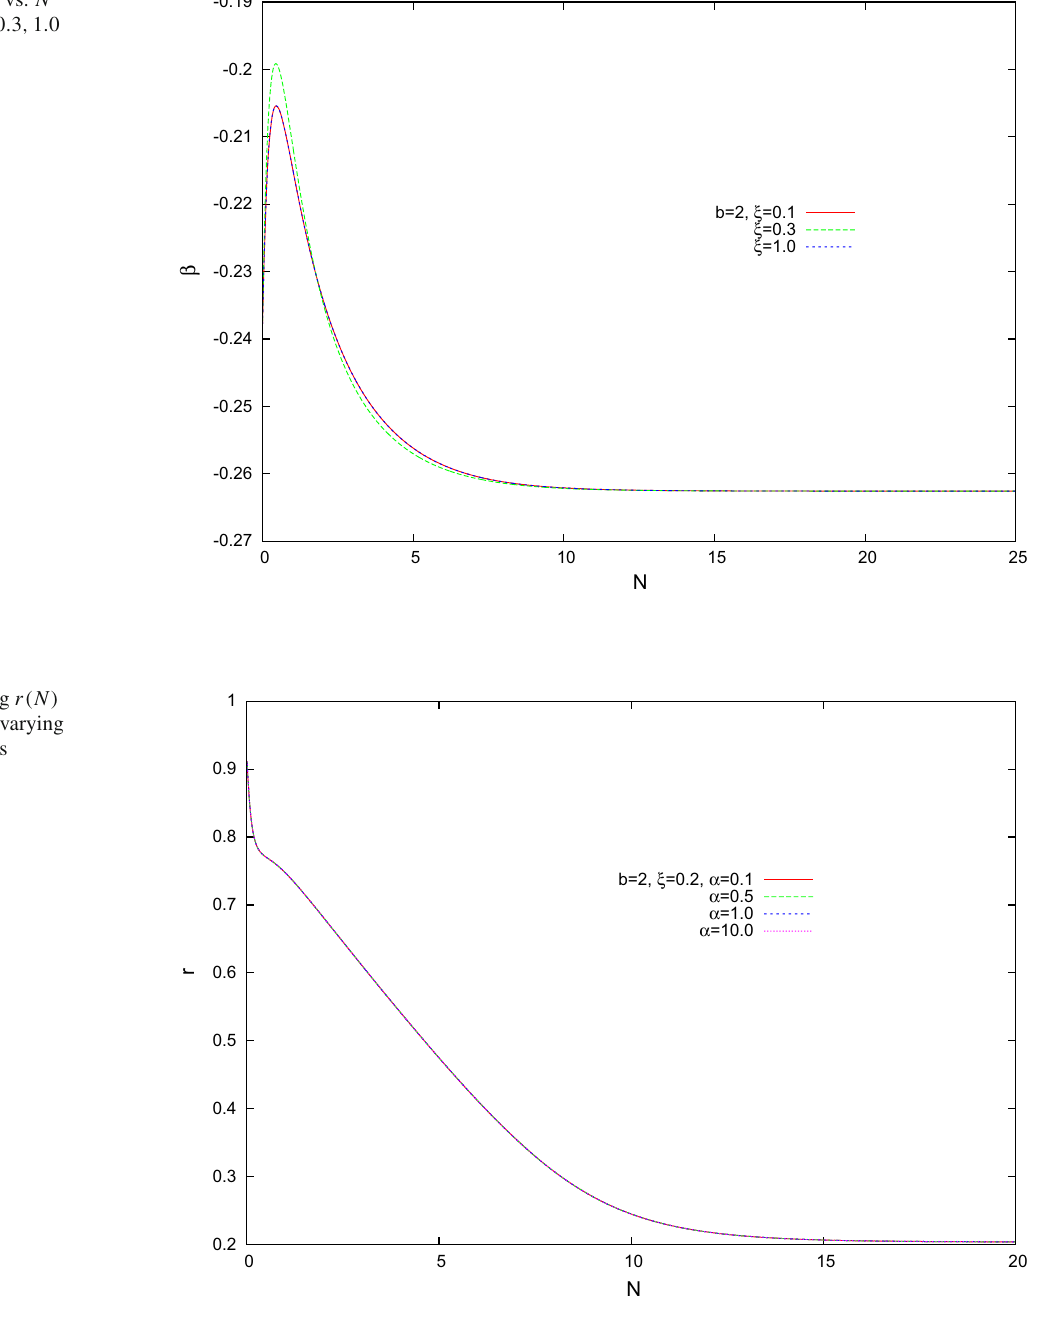
Fig. 4 The graph for β vs. N for different ξ viz. 0 . 1 , 0 . 3 , 1 . 0